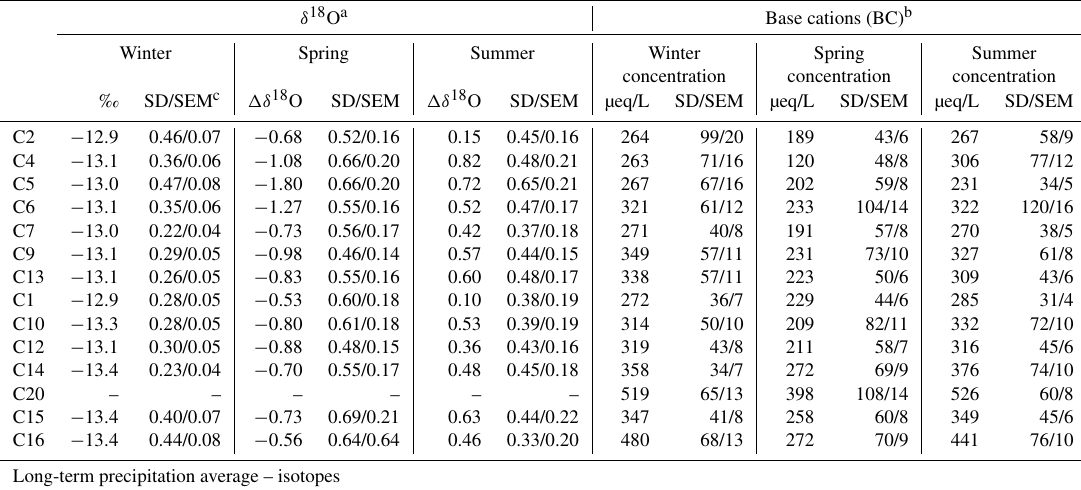
Table 2. Seasonal stream chemistry . The table includes average winter signatures (‰) and the average difference between annual winter– spring and winter–summer signatures ( (cid:49)δ 18 O). The table also includes average winter, spring, and summer BC